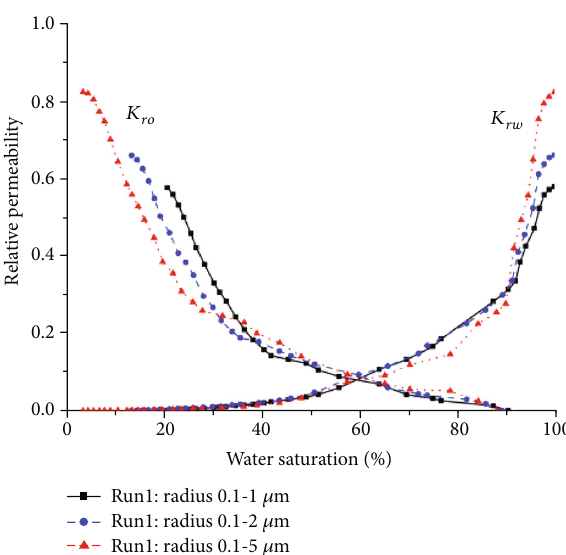
Figure 7: E ff ect of coordination number on relative permeability.